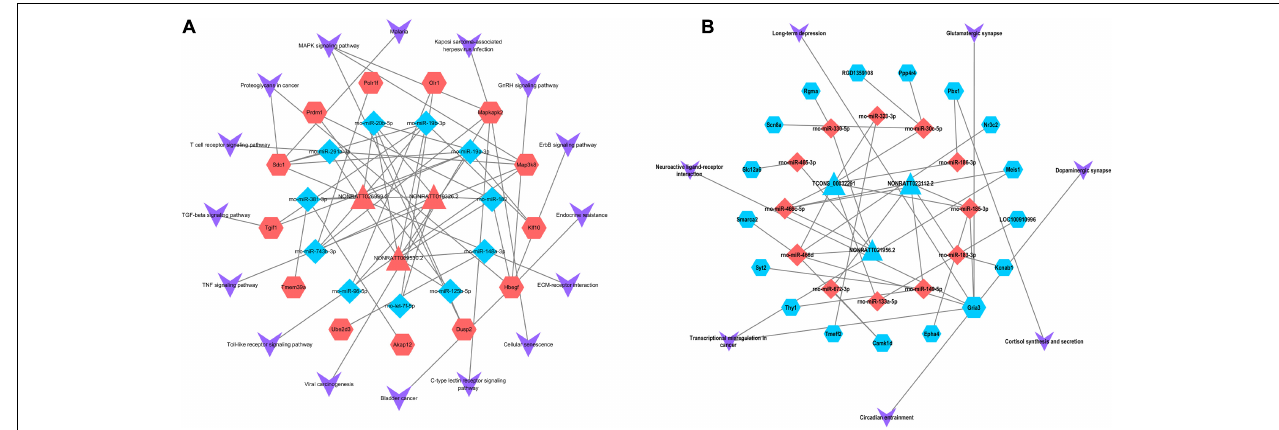
FIGURE 5 | Pathway analysis of the key lncRNAs associate ceRNA network. The ceRNA-pathway network was constructed with the six candidate lncRNAs. Triangle nodes indicate dysregulated lncRNAs, regular hexagon nodes represent mRNAs, and diamond nodes represent dysregulated miRNAs. The blue nodes of lncRNAs, mRNAs and miRNAs indicate downregulated expression, while the red nodes indicate upregulated expression. The shape of V indicates the pathways in which lncRNAs, miRNAs and mRNAs might involve. (A) The upregulated key lncRNAs and related ceRNA-pathway network. (B) The downregulated key lncRNAs and related ceRNA-pathway